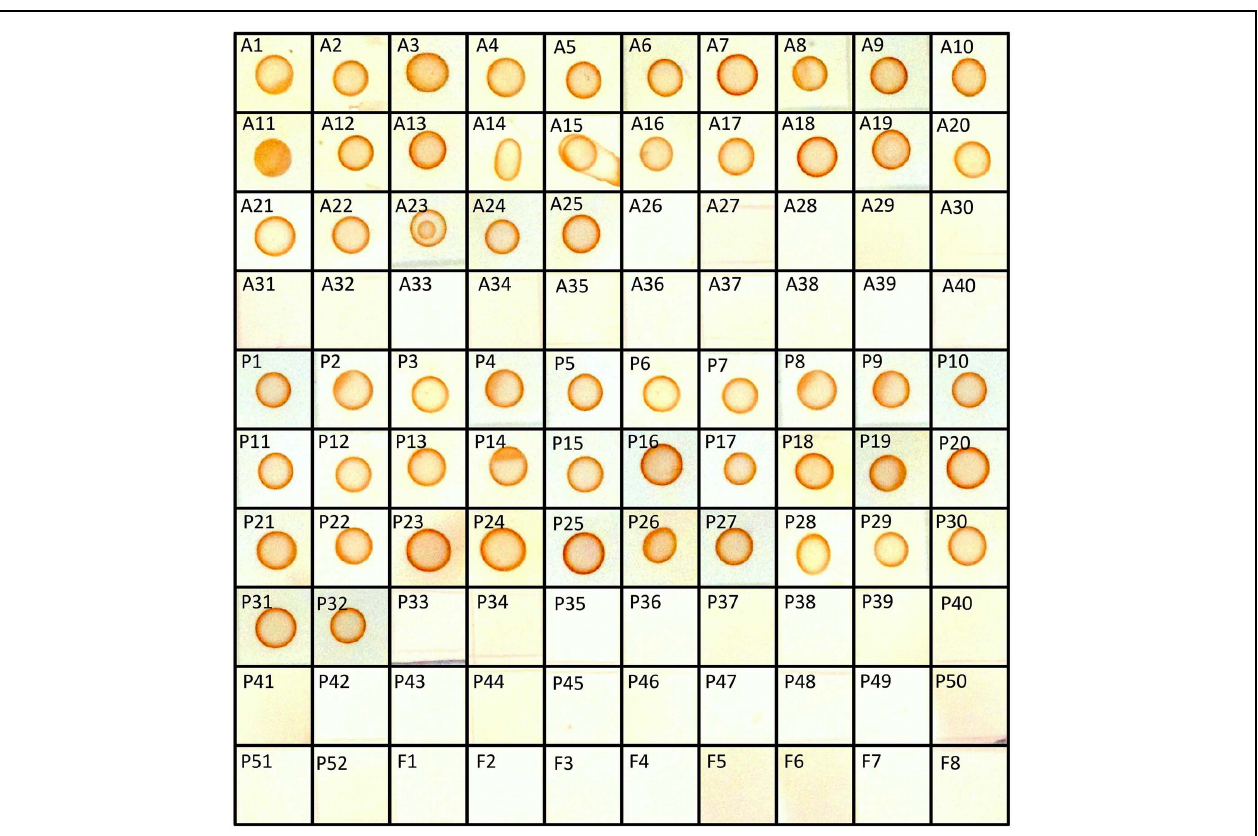
FIGURE 6 | Detection of OTA positive fungal cultures by s-dot ELISA.